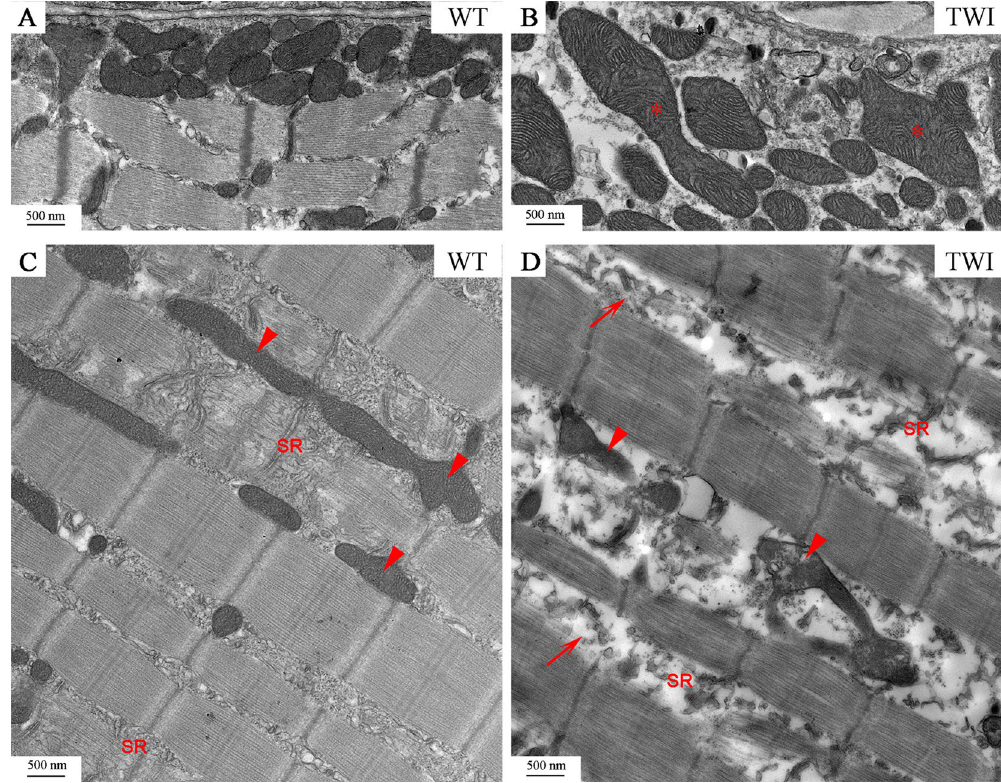
Figure 7. P30 Gastrocnemius muscle mitochondria and sarcoplasmic reticulum. ( A,B ) Representative micrographs of gastrocnemius subsarcolemmal mitochondria in WT and TWI mice. * Indicate swollen mitochondria. ( C,D ) Qualitative characterization of intermyofibrillar mitochondria. Arrowheads indicate representative mitochondria. SR indicates sarcoplasmic reticulum Arrows in D indicate